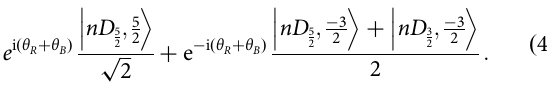
Fig. 2 Rydberg superposition states. a The desired Rydberg superposition could be controlled by the polarization angles θ R , B of the two linearly polarized fi elds with Rabi-frequencies Ω R , B propagating along the z direction. b Decomposing each of the linearly polarized lights circularly polarized elements, the transitions shown by dashed lines would form destructive interference when θ R − θ B = π /2, leading to the superposition (cid:1) (cid:1) of ð e i ð θ R þ θ B Þ m j ¼ 5 = 2 allows tunning the in-plain inter-atomic distance. The d xy and e xz cross-sections of Rydberg-Fermi interaction. The excited Rydberg superposition state would be further con fi ned around the position of plaquette atoms and hence enhances the interaction. Red and White ovals present the qubit-dependent position of 0 j i and 1 j i